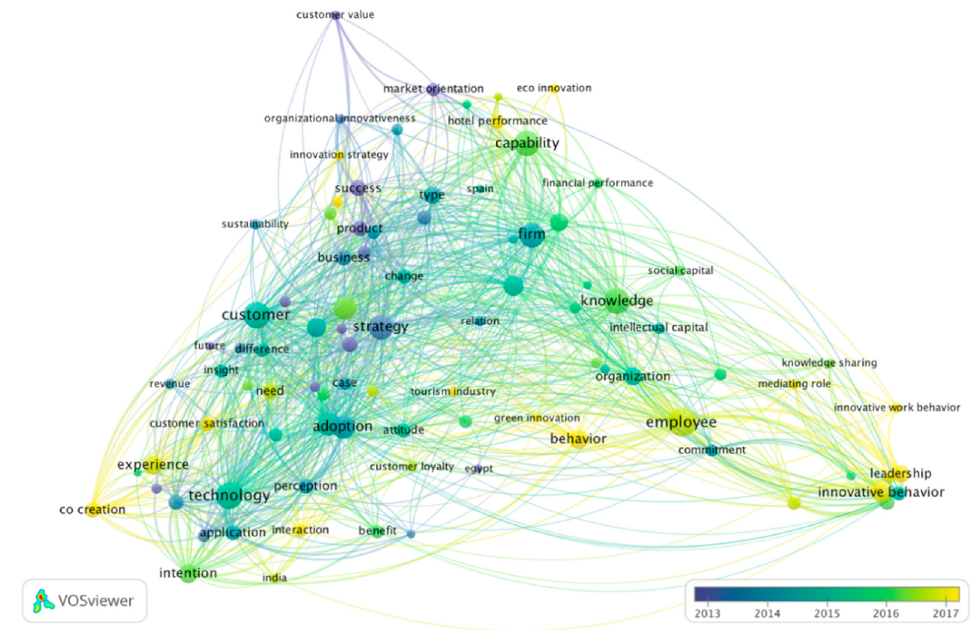
Figure 4. Temporal overlay on word co-occurrence map.